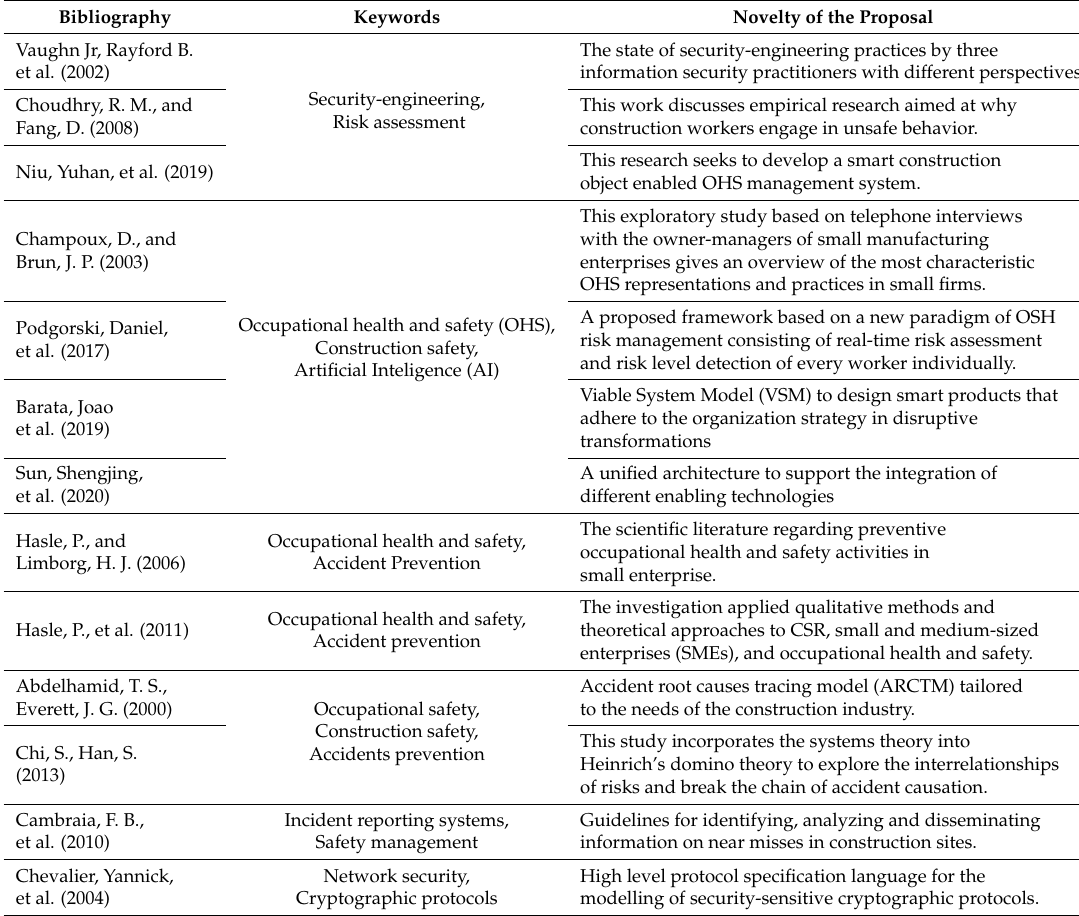
Table 1. OSH-related